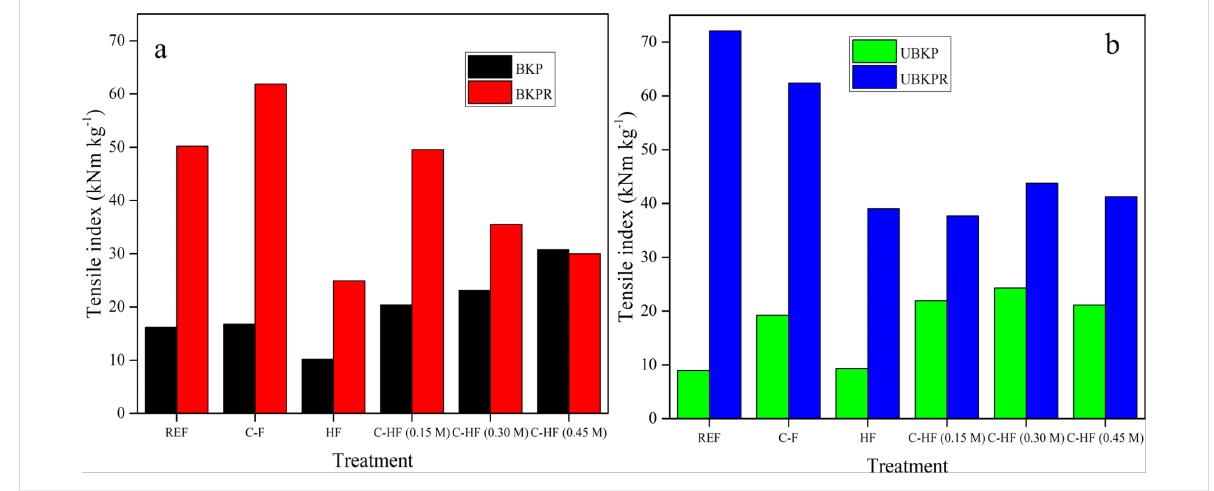
Figure 11: Tensile strength index for (a) BKP and BKP-R, (b) UBKP and UBKP-R.